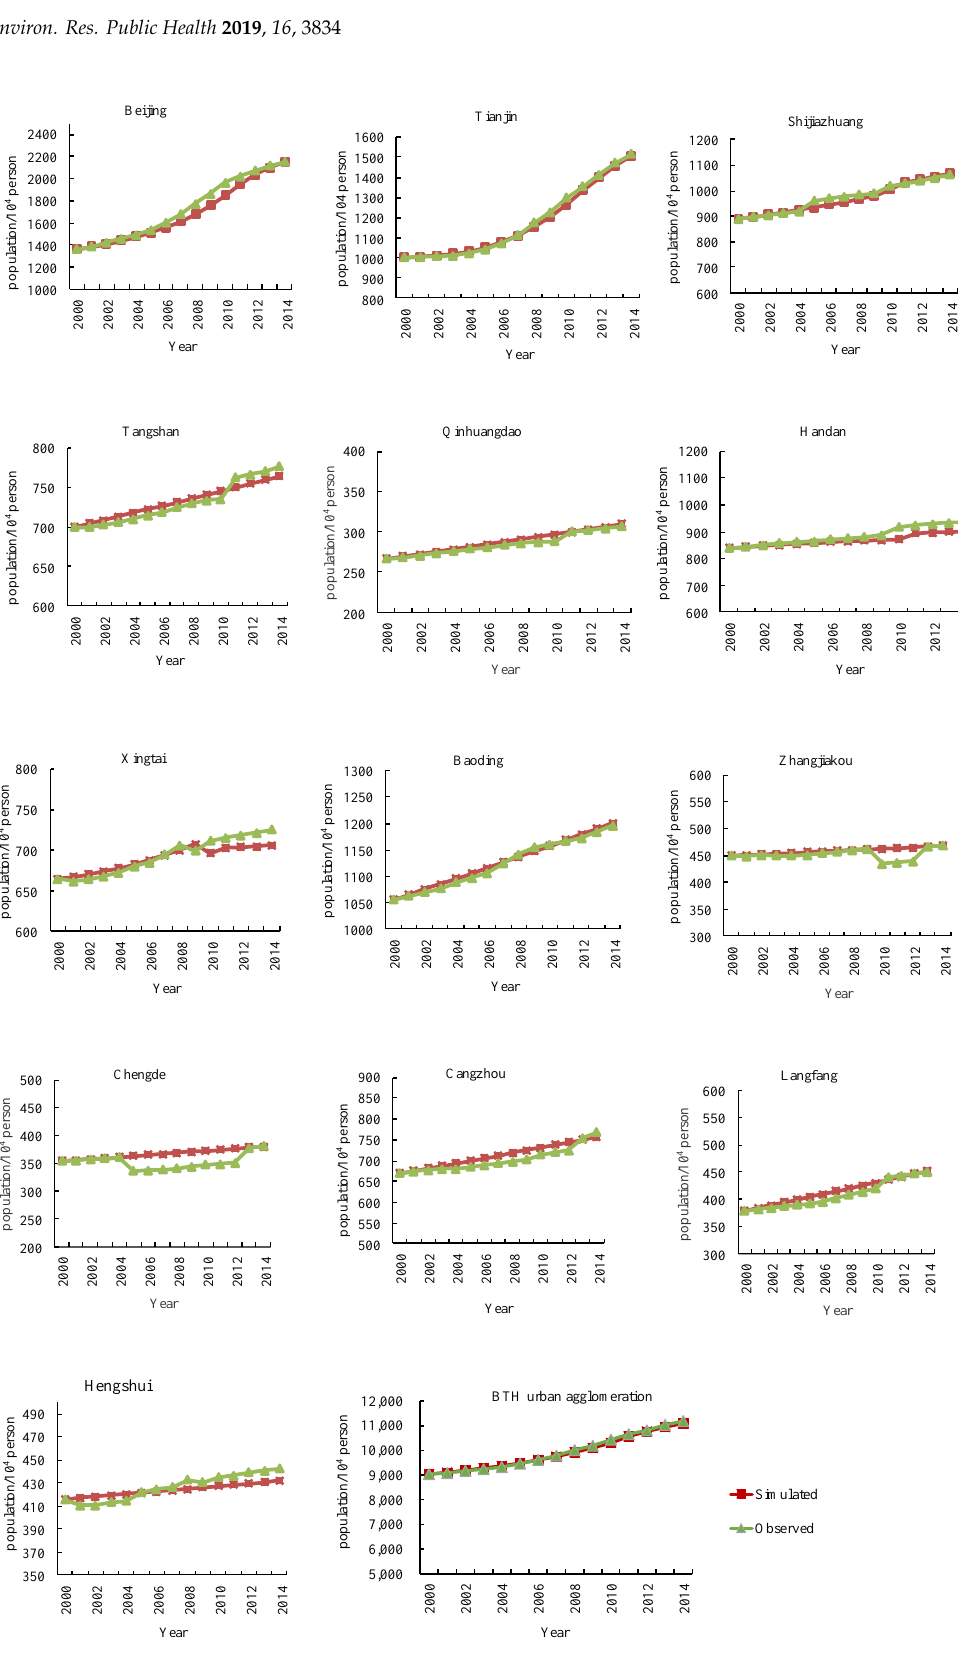
Figure 4. The comparison between observed and simulated results of population in 13 cities in the Beijing–Tianjin–Hebei (BTH) urban agglomeration.